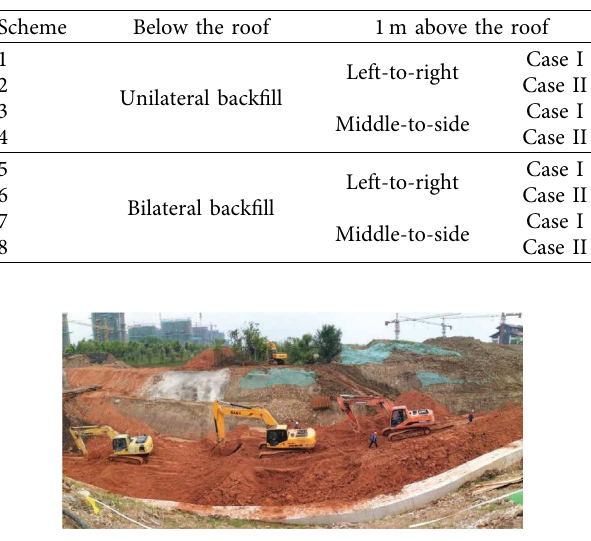
Figure 4: Diagram of backfll construction schemes for the utility tunnel. Table 1: Designed backfll construction scheme of the utility tunnel.